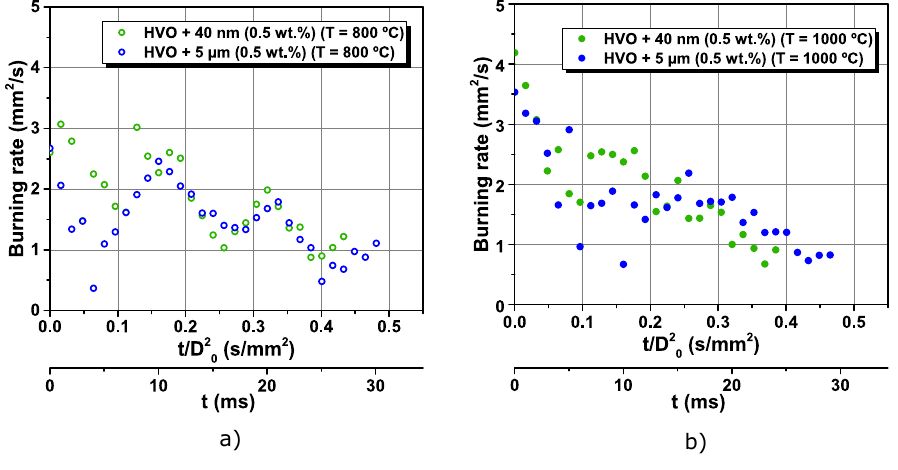
Figure 15. Temporal evolution of burning rate at ( a ) T = 800 ◦ C and ( b ) T = 1000 ◦